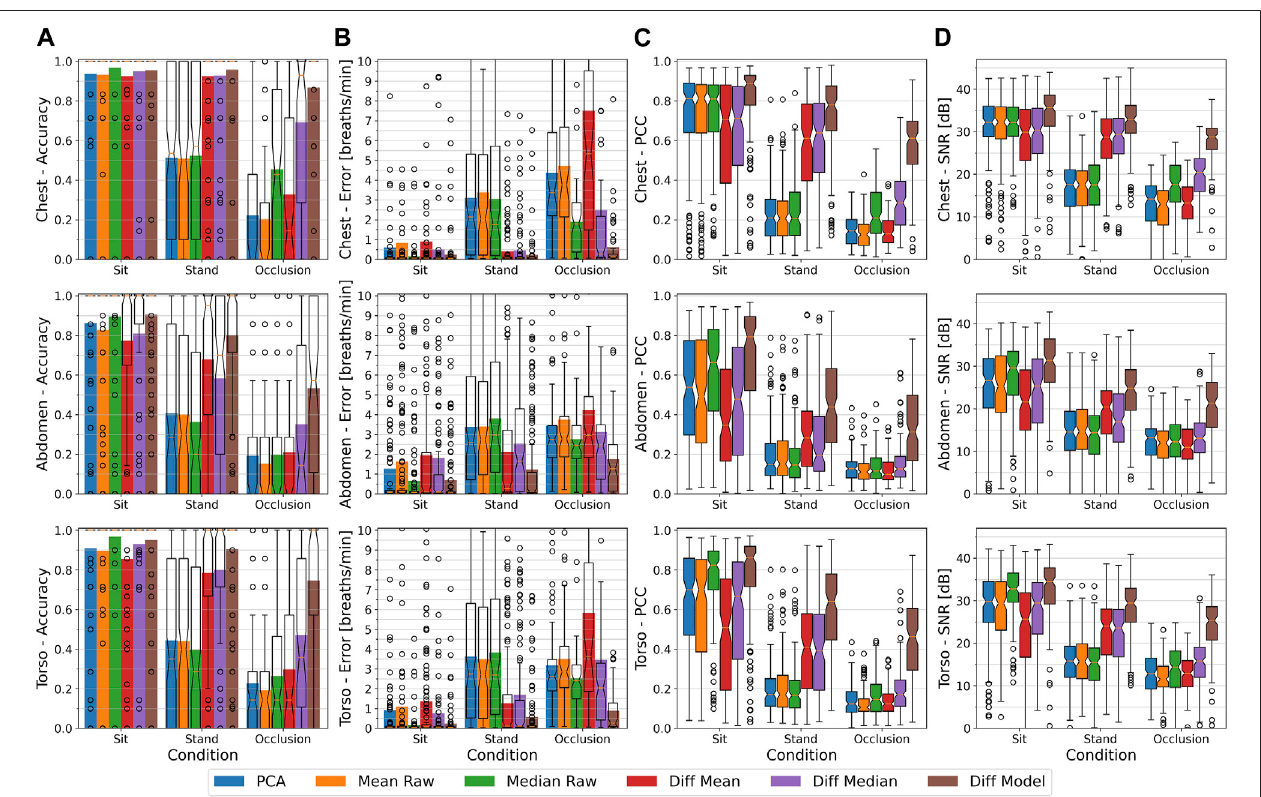
FIGURE6| From (A – D) :Therespiratoryrateaccuracy,errorsinbreathperminute,PearsonCorrelationCoef fi cientw.r.t.thegroundtruthsignal,andsignaltonoise ratioofthedifferentmethods.Plotsareseparatedfromtoptobottombythechest,abdomen,andtorsoregionandbythesitting,standing,andocclusioncondition,with all distances (1 – 4 m) and respiratory rates (10 and 15 bpm) combined. Accuracy and error metrics use a Fast Fourier Transform window with a length of 48 s. The colored bars show the averages, while overlay box plots show median (middle parts) and whiskers marking data within 1.5 IQR. Sitting results for all methods in a much clearer signal than standing upright, with standing and occlusion (holding a cup and performing drinking gestures, right measures) performing worse than just standing upright.